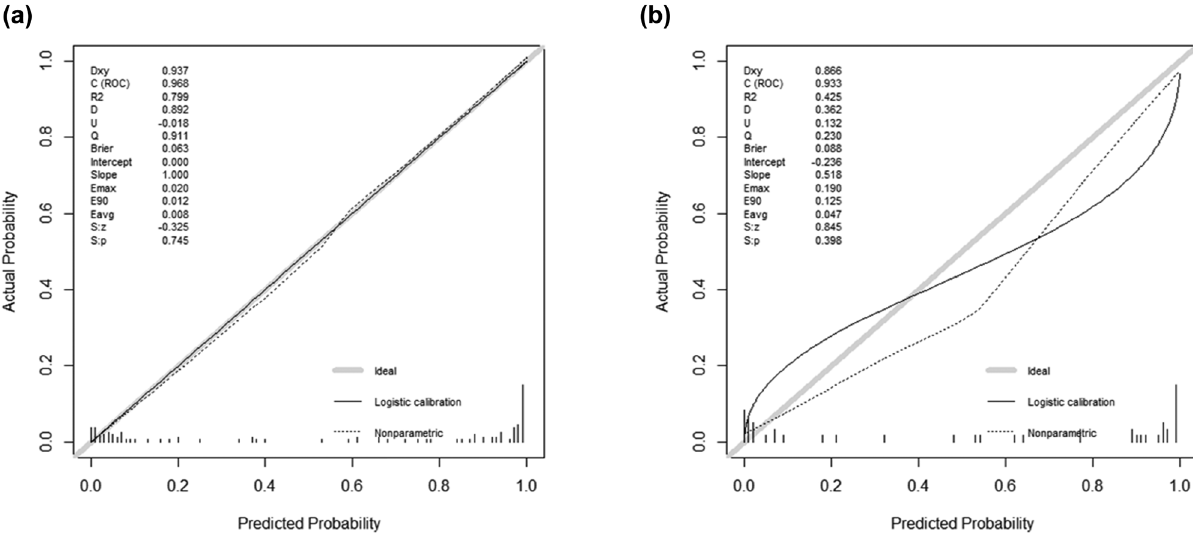
Figure 4: Calibration curves for training and validation of the nomogram. ( a ) Training cohort. ( b ) Validation cohort. The x - axis represents the nomogram - predicted probability and the y - axis represents the actual probability of severe HFRS. The black solid line represents the predictive performance of the nomogram, and the diagonal gray line represents the ideal nomogram model. HFRS, hemorrhagic fever with renal